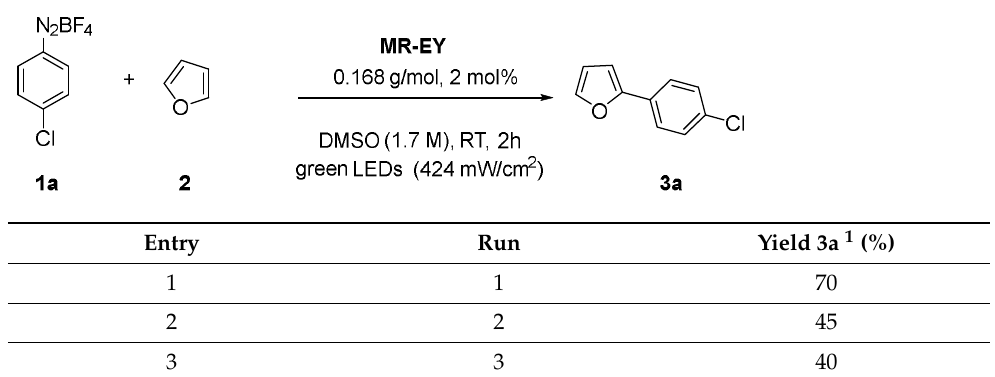
Table 3. Recycle of MR-EY.